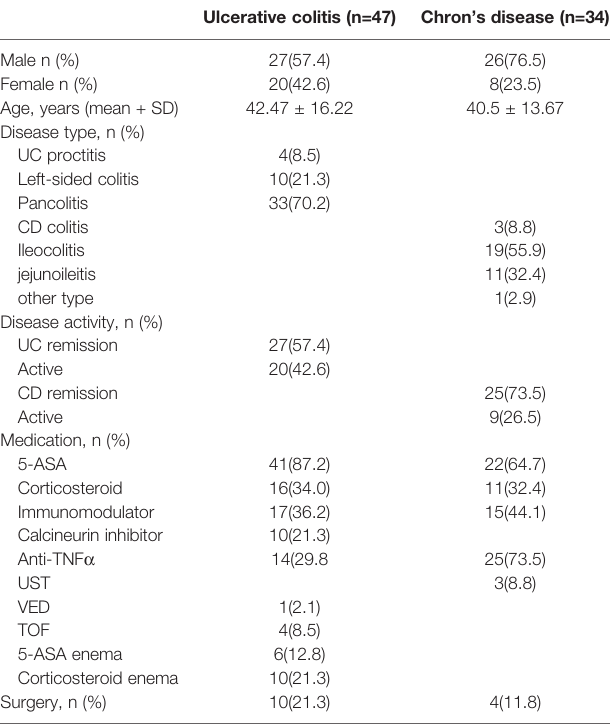
TABLE 1 | Demographic data and the clinical features of the enrolled